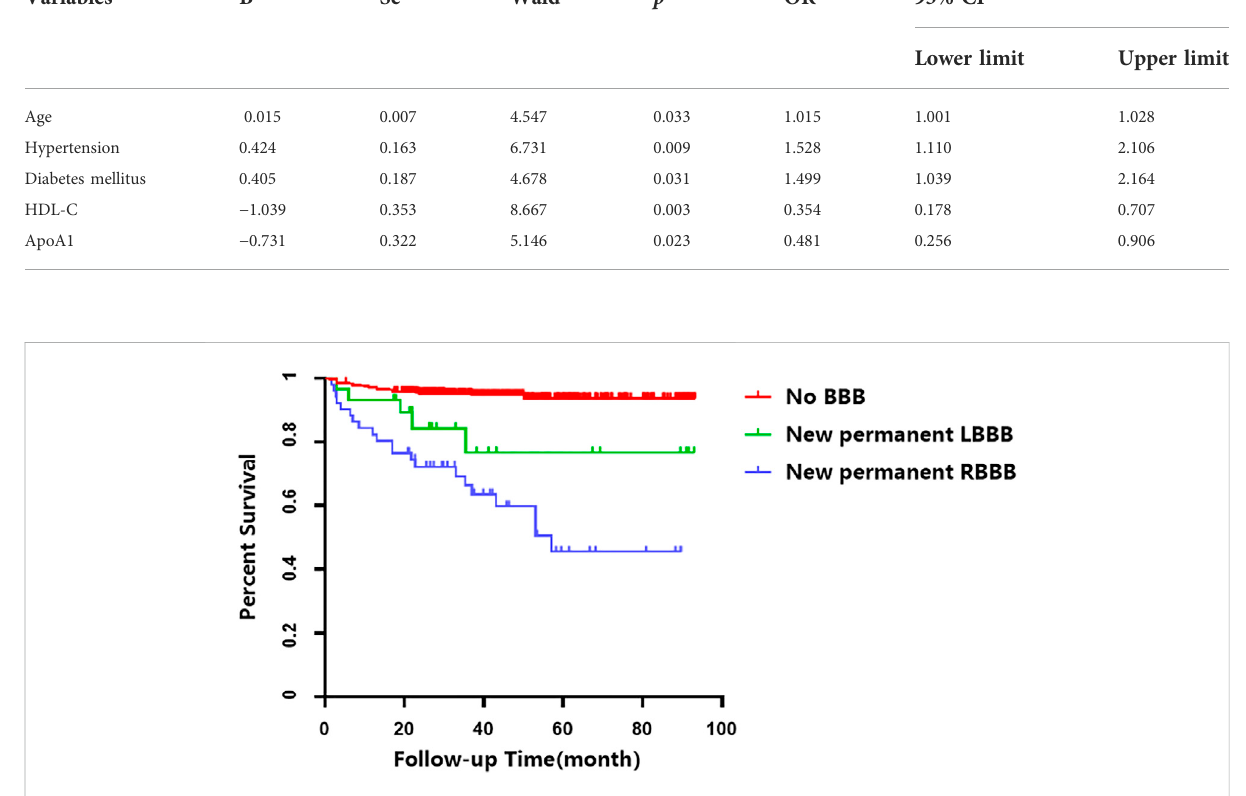
FIGURE 2 Cumulative survival of MACCEs in patients with STEMI who underwent PCI.